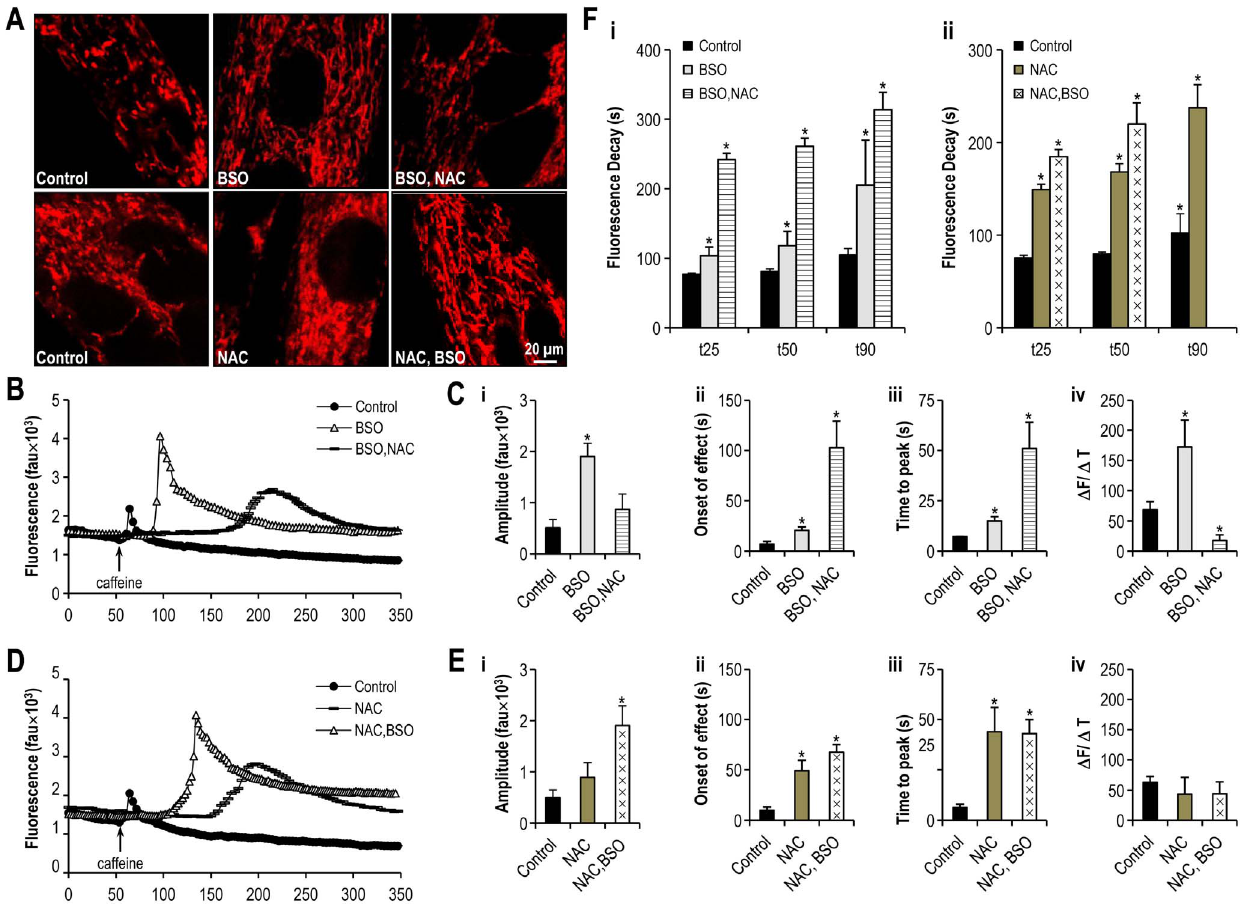
Figure 8. Altering Redox state alters both mitochondrial plasticity and SR calcium handling. Panel A: Confocal microscopy images of differentiated C2C12 myotubes having been previously treated with BSO, NAC or both, and loaded with TMRE. Panels B and D: Representative tracings of the fluorescence profile of myotubes cultured under oxidative stress or reducing agent or both and loaded with flou-4 prior to the application of caffeine to trigger SR calcium release (BSO, BSO + NAC, NAC, NAC + BSO v. control). Panels C and E: Objective mean quantitative data for caffeine induced calcium release and fluorescence kinetics of cells with altered redox states (BSO, BSO + NAC, NAC, NAC + BSO v. control). Panel F: Histogram displaying the mean quantitative data relating to the normalization of fluorescence following caffeine application (BSO, BSO + NAC, NAC, NAC + BSO v. control). * Denotes p , 0.001 ANOVA, n=20 per group.